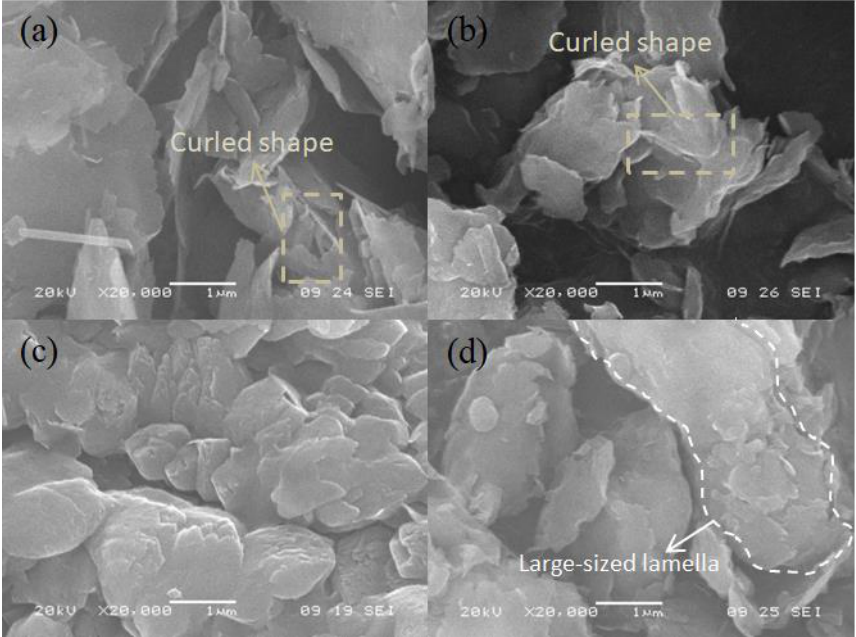
Figure 2. The microstructure of untreated and treated layered silicates: ( a ) Montmorillonite (MMT); ( b ) rectorite (REC) [17]; ( c ) organic montmorillonite (OMMT); ( d ) organic rectorite (OREC).